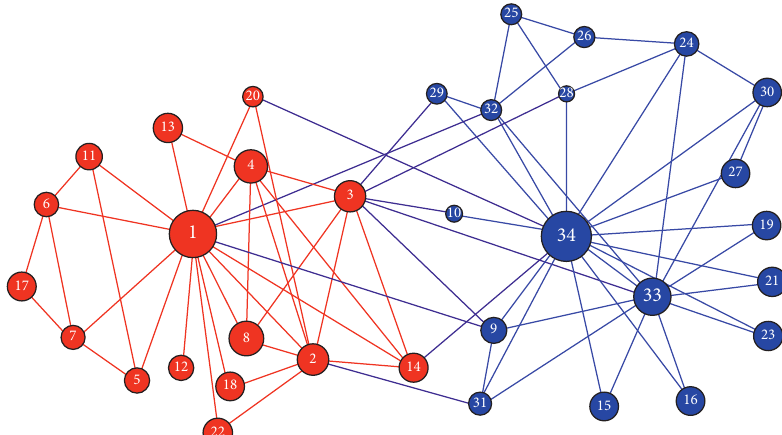
Figure 1: The balance factor of nodes in the Karate network.